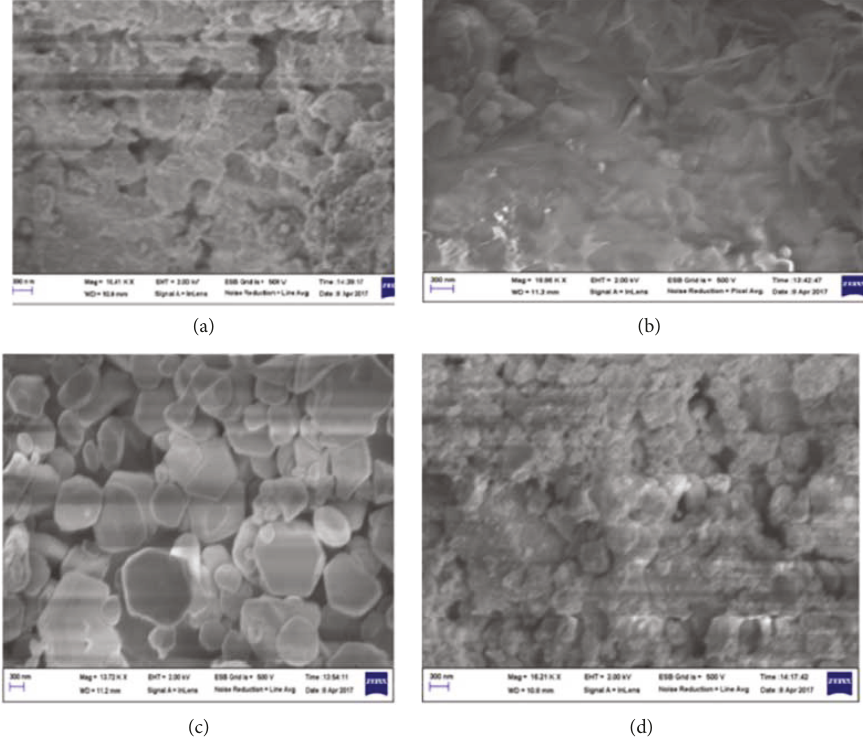
Figure 3: SEM images of (a) pure TiO